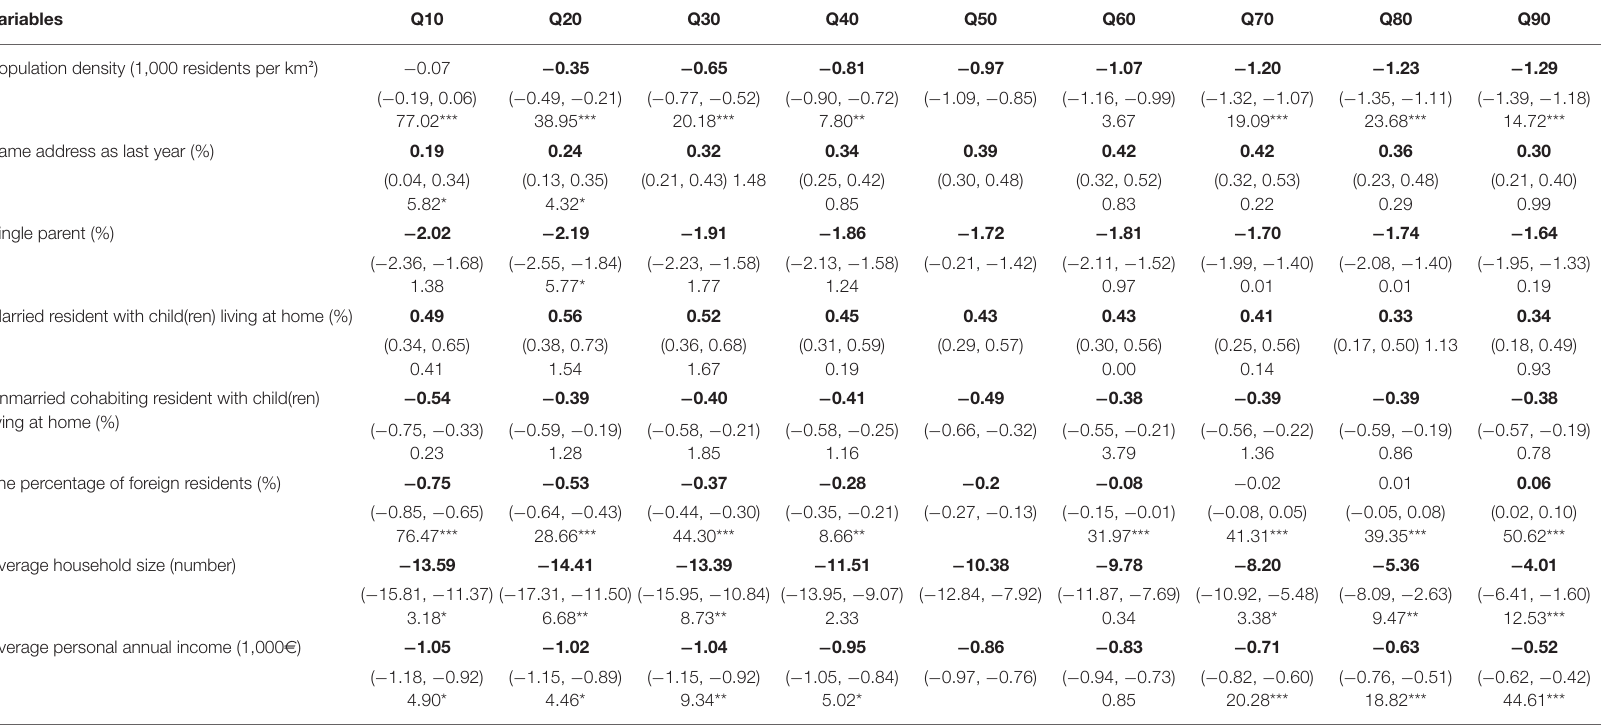
TABLE 3 | Multivariable quantile regression coefficient and 95%CI of the determinants of coverage in the BCSP at the 10th (Q10) to the 90th (Q90) quantiles. Variables Q10 Q20 Q30 Q40 Q50 Q60 Q70